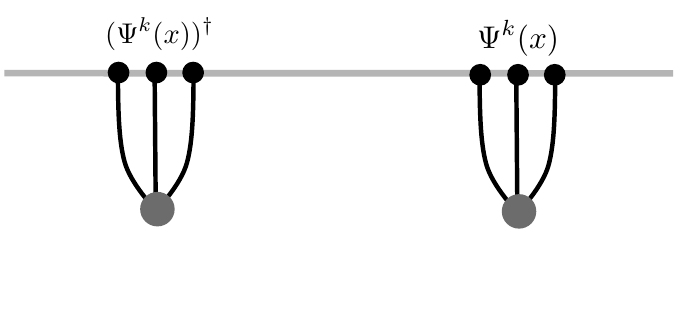
Figure 5: Once k Wilson lines can end on a bulk monopole, the 2-point function of widely separated inser- tions of Ψ k ( x ) will be dominated by configurations like this, where the answer is independent of